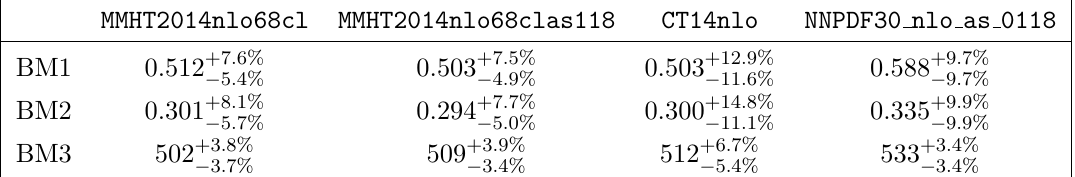
Table 5. Cross section (in fb) of ~ u L ~ u y di(cid:11)erent PDF sets. All details as for table